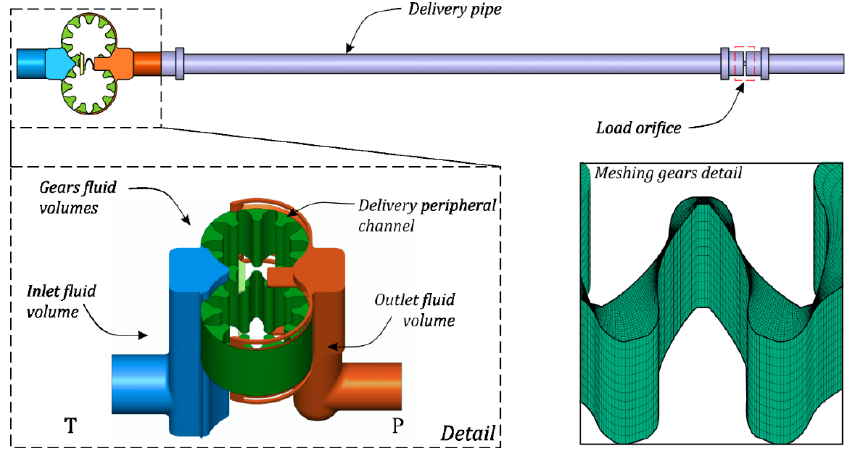
Figure 6. Computational volumes in the pump model developed in SimericsMP+.